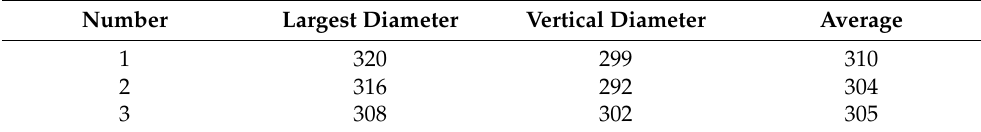
Table 4. Fluidity of grouting material in 30 min (unit: mm).